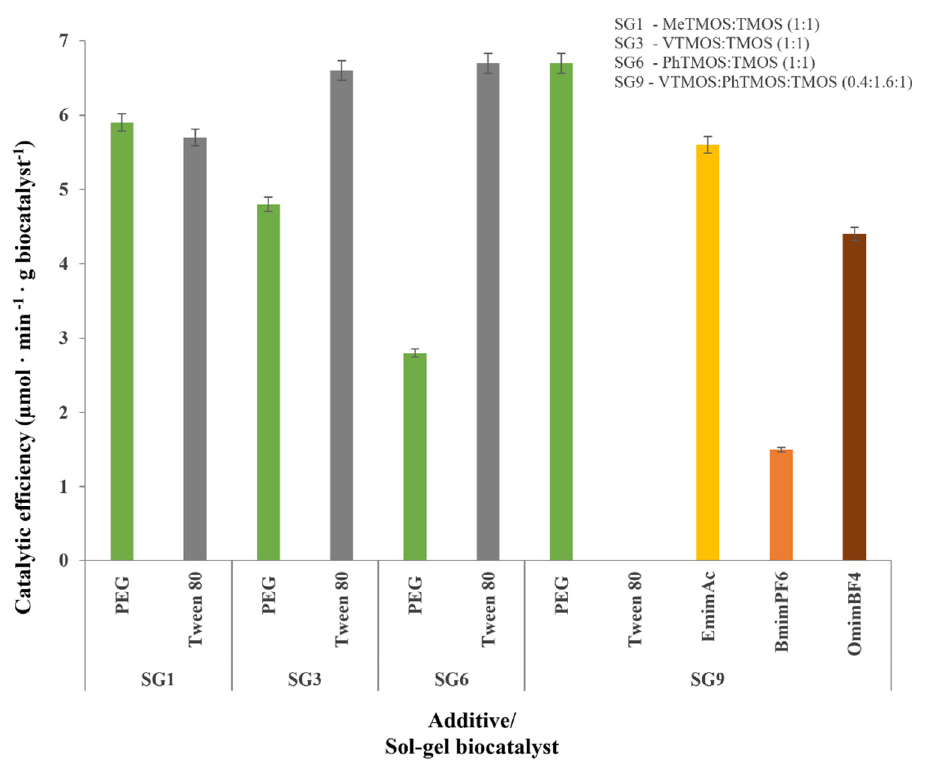
Figure 1. Influence of the nature of the immobilization additive on the catalytic efficiency of Cellic CTec2 cellulase that was immobilized by sol–gel entrapment with binary and ternary silane net-